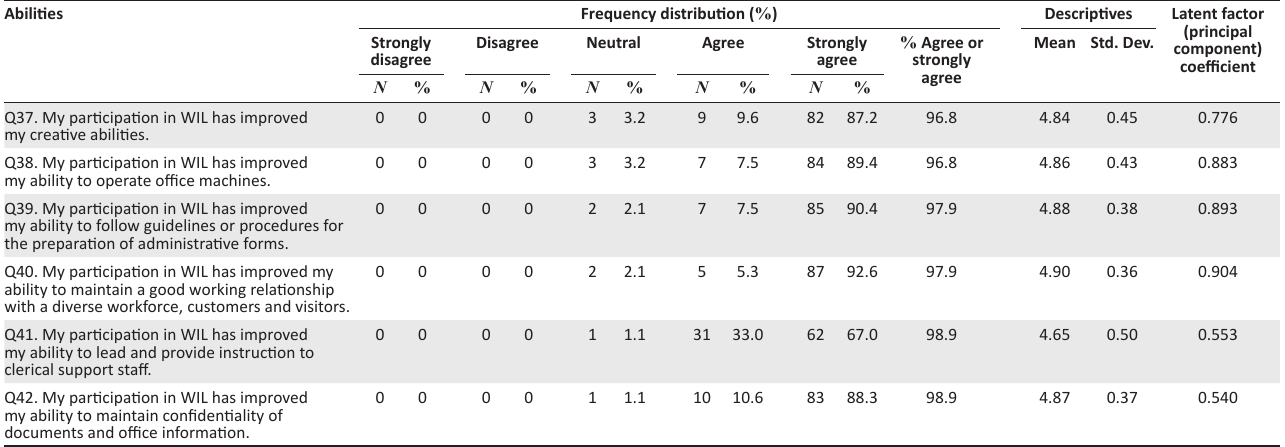
TABLE 6: Abilities enhancement. Abilities Frequency distribution ( % )